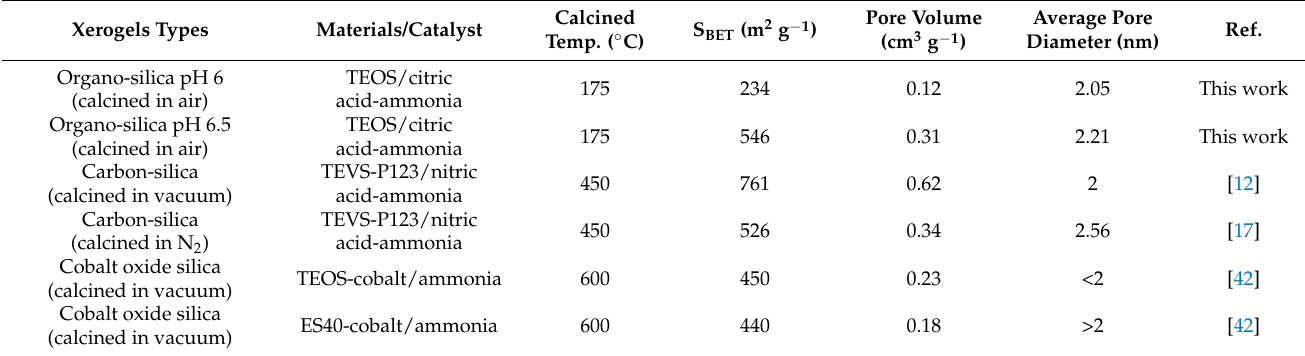
Table 4. Surface properties of organo-silica xerogels at varied types.